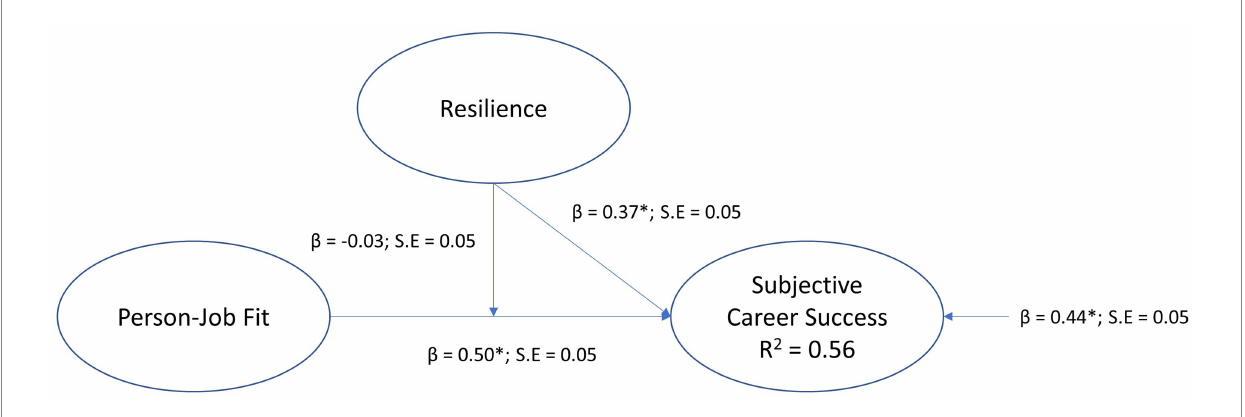
FIGURE 1 Moderation model for resilience.